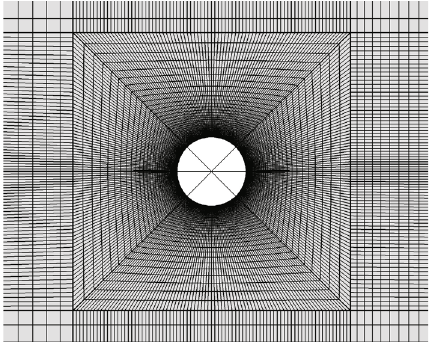
Figure 2: Close-up view of the mesh around the cylinder surface with 42 × 80P1 + P1 elements in each quartile. Table 1: Characteristics of independent mesh used in this